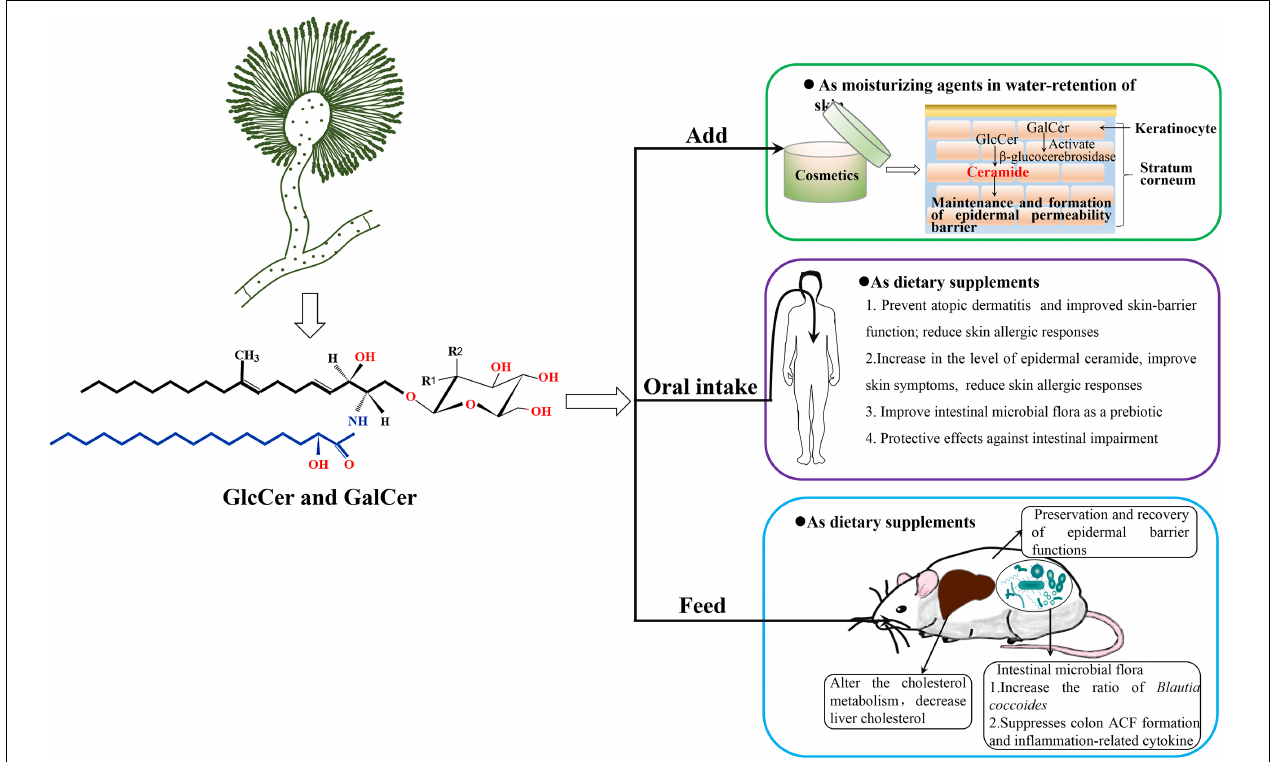
FIGURE 4 | The potential application diagram of filamentous fungal glycosylceramides, taking A . oryzae as an example. A . oryzae produces GlcCers and GalCers of glycosylceramides which might be safe to add in cosmetics as moisturizing ingredient or health food products as nutritional supplements. A . oryzae glycosylceramides, which function as a prebiotic, have been confirmed to increase ratio of Blautia coccoides and significantly decrease liver cholesterol in obese mice fed with koji glycosylceramide. Monosaccharide may be either glucosyl (Glc) (R1 = OH, R2 = H) or galactosyl (Gal) residues (R1 = H, R2 = OH) in the chemical